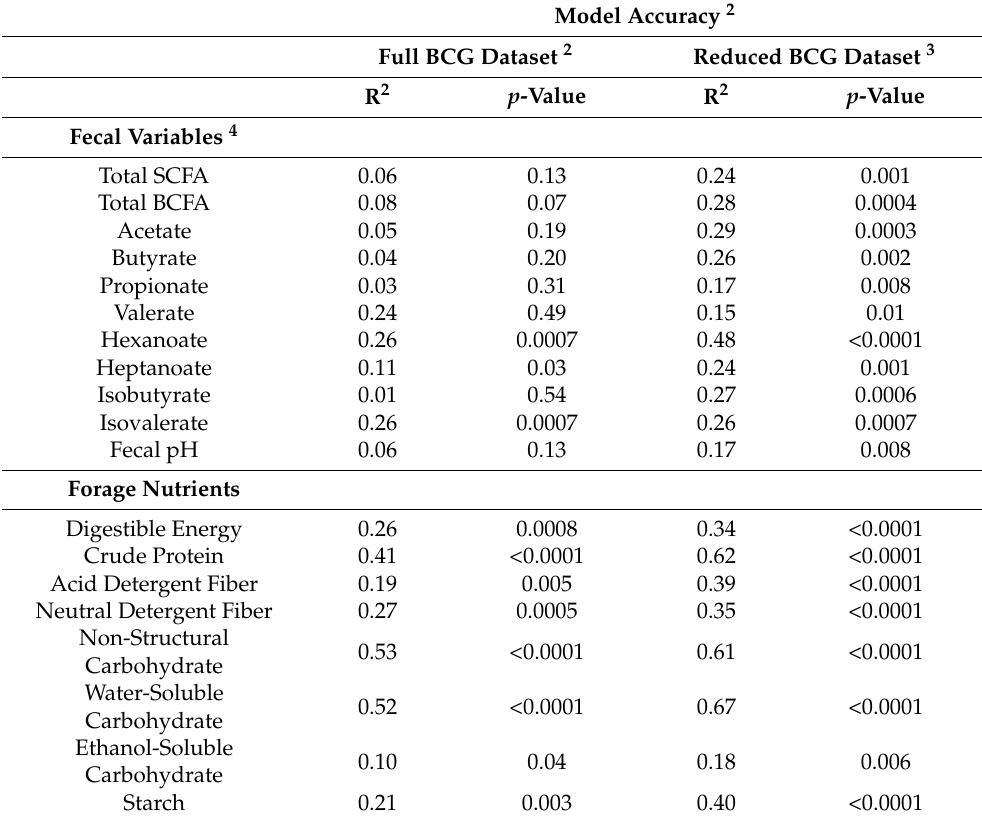
Table 7. Random forest regression accuracy 1 for predicting fecal variables and forage nutrients based on microbial